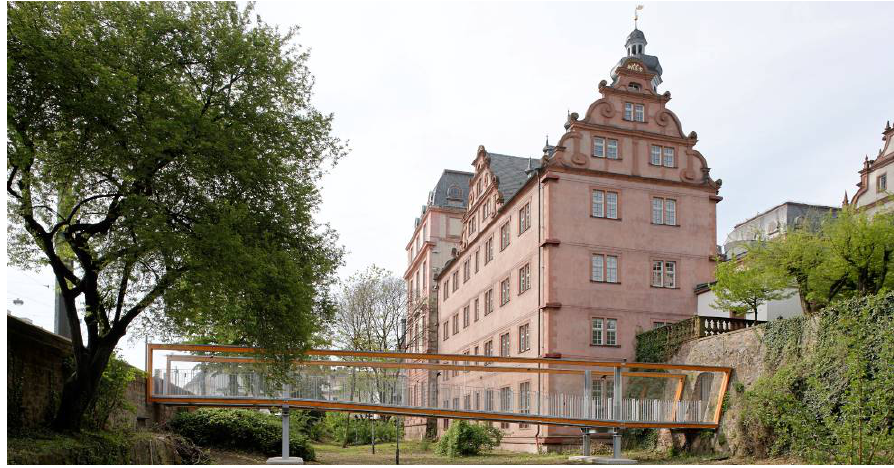
Figure 11: Prototype – palace moat bridge in Darmstadt,